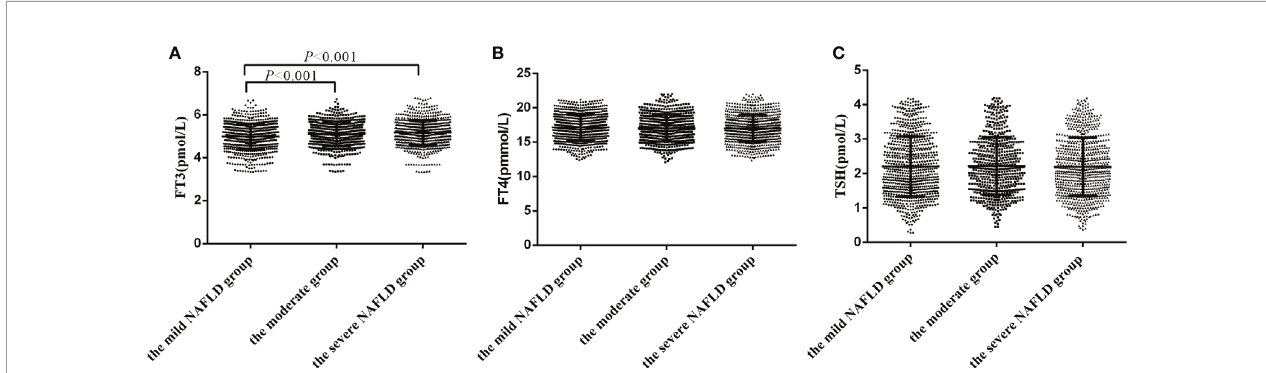
FIGURE 1 | The levels of FT3, FT4 and TSH in subjects with different severity of hepatic steatosis of NAFLD. (A) The levels of FT3 in subjects with different severity of hepatic steatosis of NAFLD; (B) The levels of FT4 in subjects with different severity of hepatic steatosis of NAFLD; (C) The levels of TSH in subjects with different severity of hepatic steatosis of